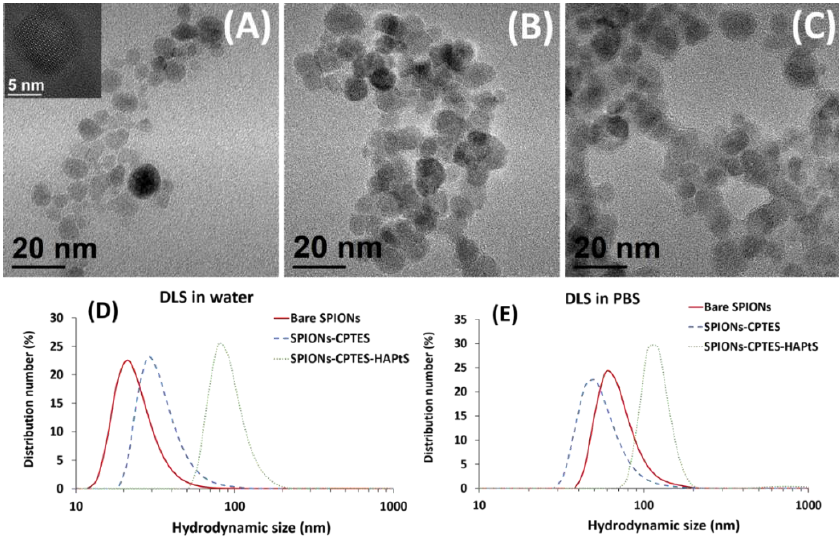
Figure 5. Transmission electron microscopy (TEM) images of ( A ) bare superparamagnetic iron nanoparticles (SPIONs) (inset: high resolution (HR)-TEM image of one nanoparticle), ( B ) SPIONs-CPTES, and ( C ) SPIONs-CPTES-HAPtS and dynamic light scattering (DLS) curves of bare and functionalized SPIONs in ( D ) water (10 -2 NaCl) and ( E ) phosphate buffer solution (PBS) 0.1× (pH 7.4). Table 3. Physico-chemical characteristics of bare and modified SPIONs.